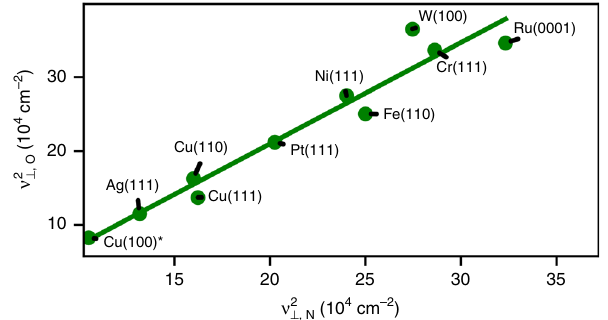
Fig. 2 Predicted VSR slopes for AH X species. Values are predicted based on Eq. (12). Labels indicate adsorbate A/B for CH X (blue), NH X (green), and OH X (red). The black line indicates parity. The fi tted slopes to DFT data are from the data in Fig. 1 and fi t according to Eq. (13). Included are the perpendicular frequencies of the adsorbates on the atop sites of the (100) (circles), (110) (triangles), and (111) (squares) facets